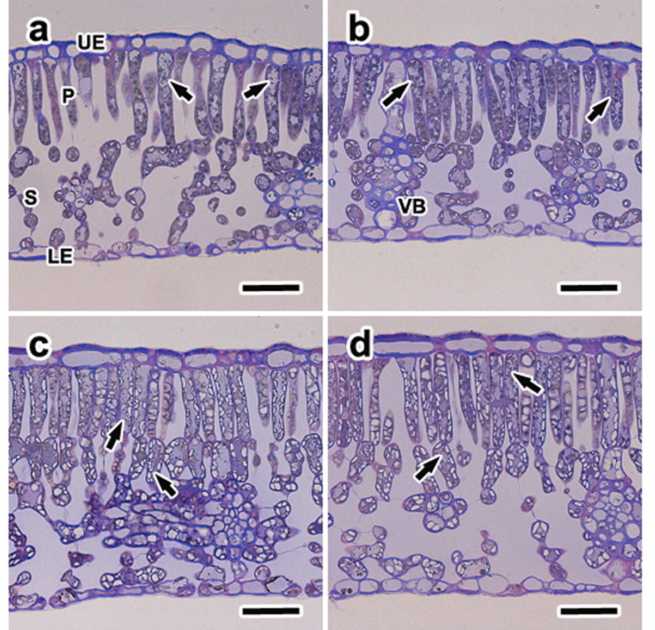
Figure 5. Micrographs of the cross sections of beech ( Fagus crenata ) leaves in all treatments. These sections were double-stained with safranin and gentian violet. ( a ) Ambient CO 2 and low nitrogen, ( b ) ambient CO 2 and high nitrogen, ( c ) elevated CO 2 and low nitrogen, and ( d ) elevated CO 2 and high nitrogen. The arrows indicate phenolic compounds. LE; lower epidermis, P; palisade layer, S; spongy parenchyma, UE; upper epidermis, VB; vascular bundle, scale bars = 20 µ m.